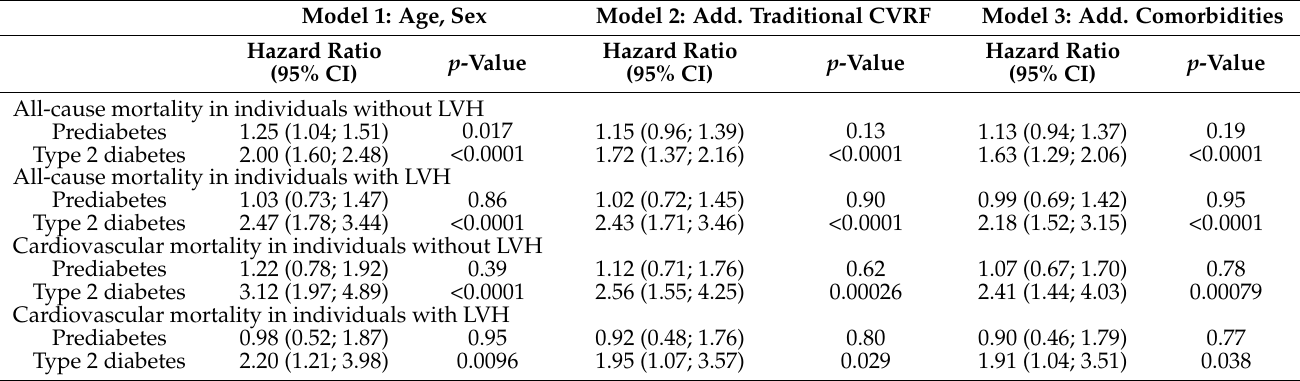
Cox regression analyses for investigation of mortality in presence and absence of LVH in prediabetes and type 2 diabetes mellitus. Four calculations were performed and each was adjusted for models 1, 2, and 3. Model 1 adjusted for age and sex. Model 2 adjusted for age, sex, hypertension, dyslipidemia, obesity, smoking, and family history of myocardial infarction or stroke. Model 3 adjusted for age, sex, hypertension, dyslipidemia, obesity, smoking, family history of myocardial infarction or stroke, myocardial infarction, coronary artery disease, stroke, atrial fibrillation, peripheral artery disease, venous thromboembolism, chronic obstructive pulmonary disease, and chronic kidney disease. CI, confidence interval; CVRF, cardiovascular risk factors; LVH, left ventricular hypertrophy.